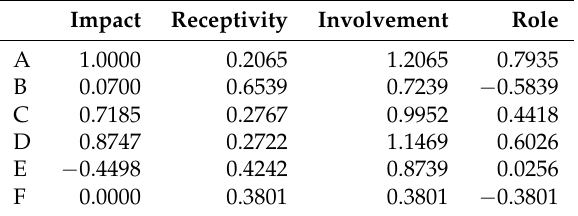
Table A1. The WINGS output for illustrative example—relative